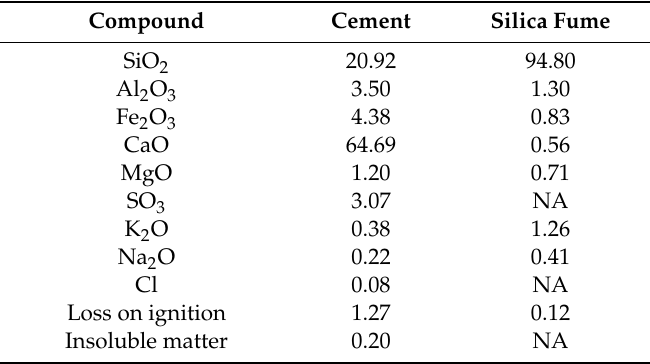
Table 2. Chemical composition of cement and silica fume (in